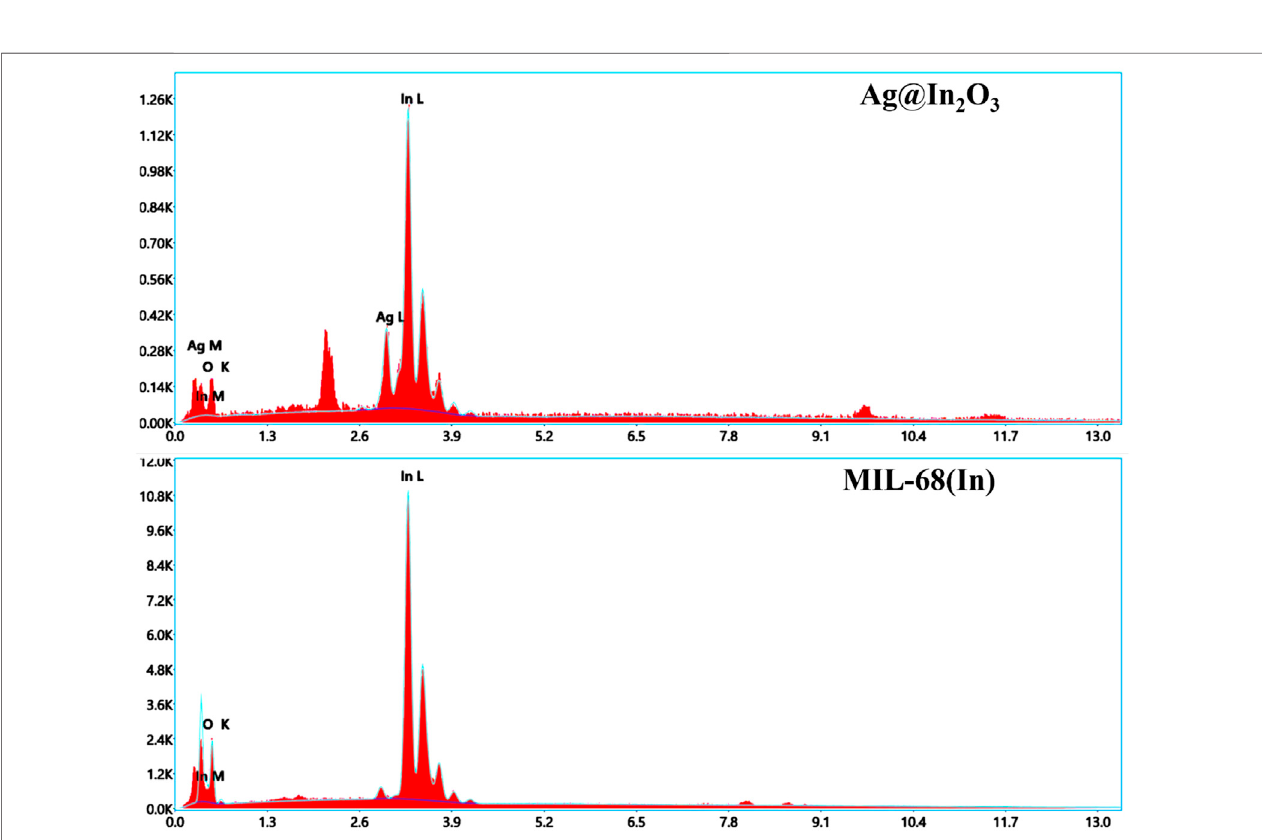
FIGURE 5 | Edx analysis of MIL-68(In) and Ag@In 2 O